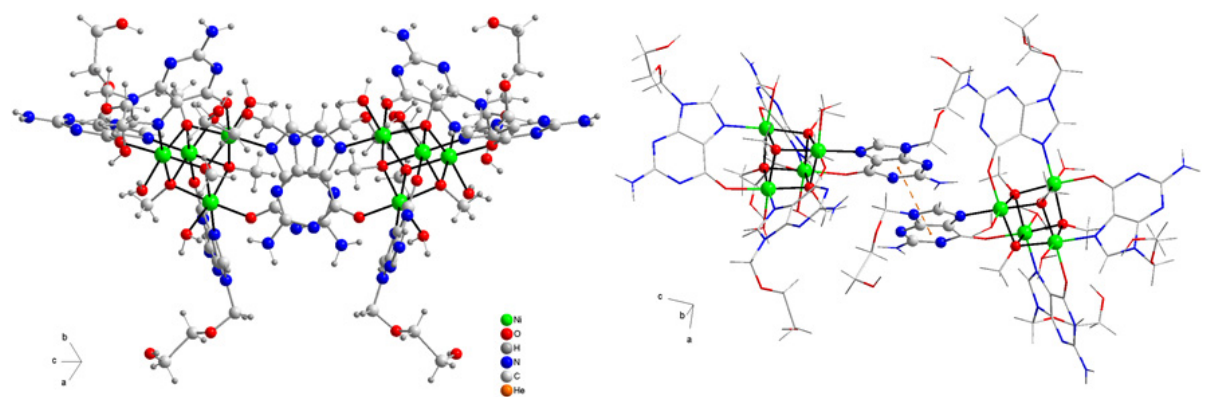
Figure 4. Two images illustrating the π -staking interactions between the six-membered pyrimidine rings of two acv-H ligands from two neighbouring cluster molecules of compound 1 .